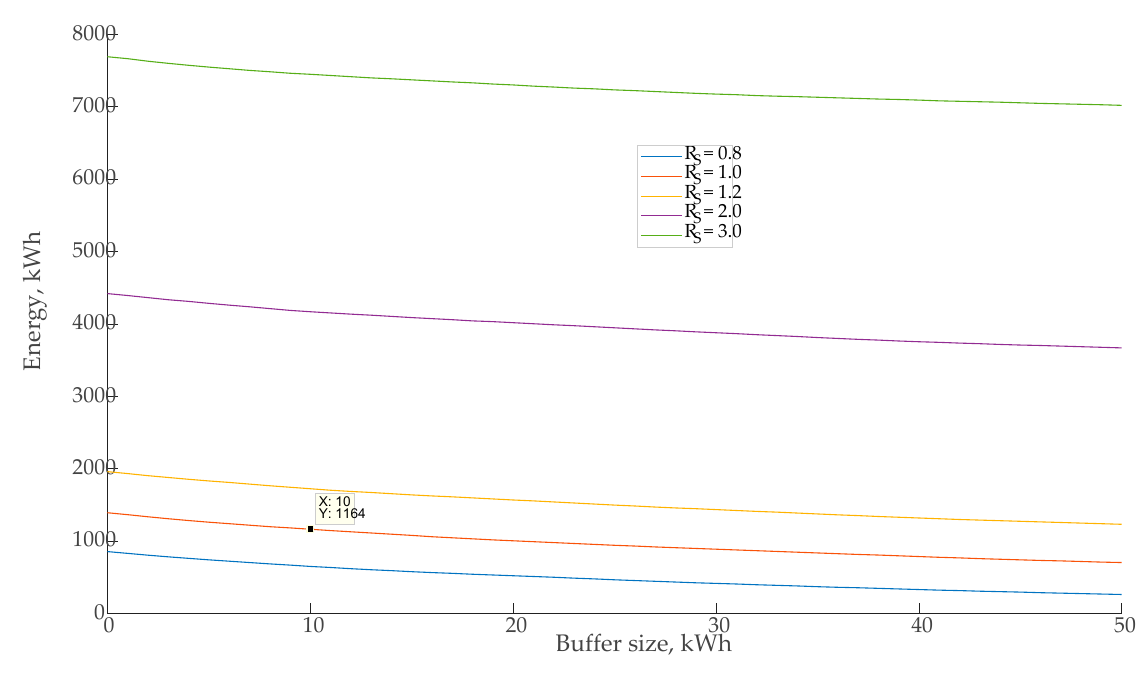
Figure 8. Energy from buffer battery (BB) to the grid.